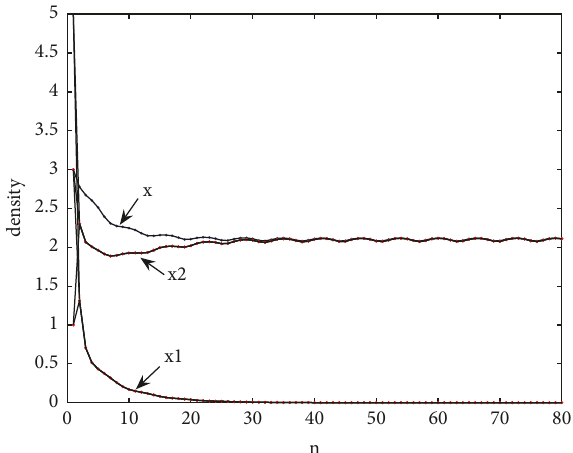
Figure 2: Dynamic behaviors of species 𝑥 1 and 𝑥 2 in (104) with initial values 𝑥 1 (0) = 1,3, 5 and 𝑥 2 (𝜗) = 1, 3, 5 for 𝜗 = −1,0 , respectively; 𝑥 is a solution of